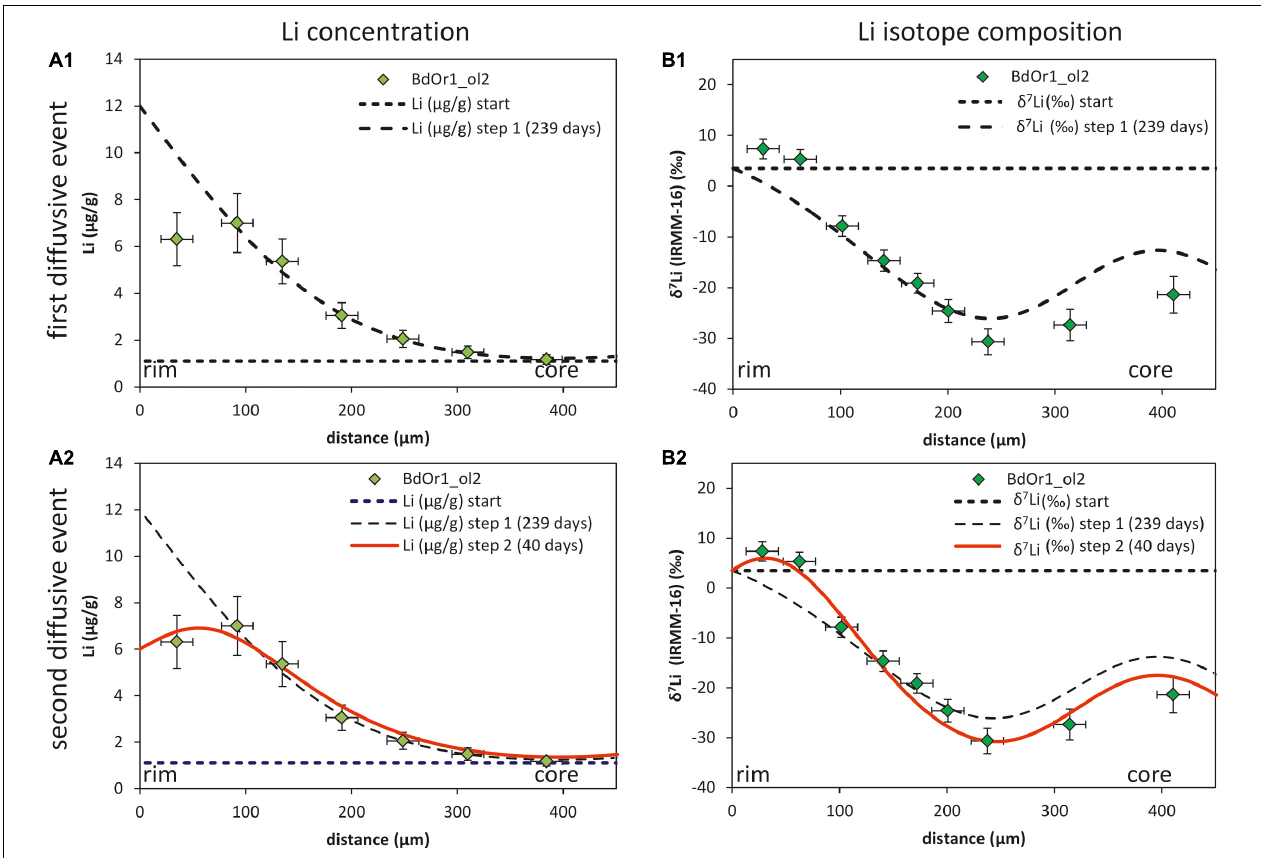
FIGURE 5 | (A1) and (B1) show the Li concentration and isotopic composition of the first diffusion event for BdOr1_ol2 with a duration of t = 239 days, C core = 1.1 µ g/g, C rim1 = 12 µ g/g and β = 0.25. (A2) and (B2) show the model for the second diffusion event (which is based on the first diffusion event) with t = 40 days, C rim2 = 6 µ g/g and β = 0.2, the Li diffusion coefficient was determined by fitting the observed Li concentrations and isotope compositions to 5.5*10 - 16 m 2 /s. Core Li concentrations and isotope compositions are marked by a dashed